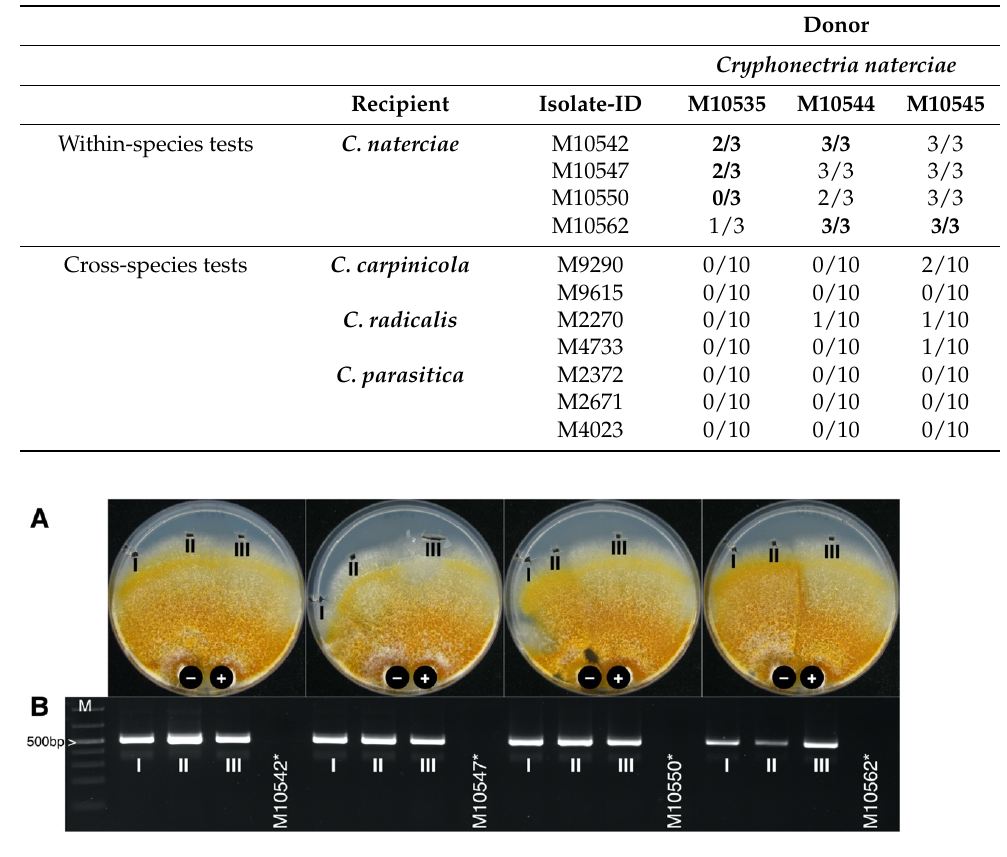
Table 2. Results of the horizontal transmission of CnFGV through co-cultivation of donor and recipient Cryphonectria strains. The numbers indicate the number of successful virus transmissions per number of trials. Bold numbers highlight incompatibility among isolates of C. naterciae .